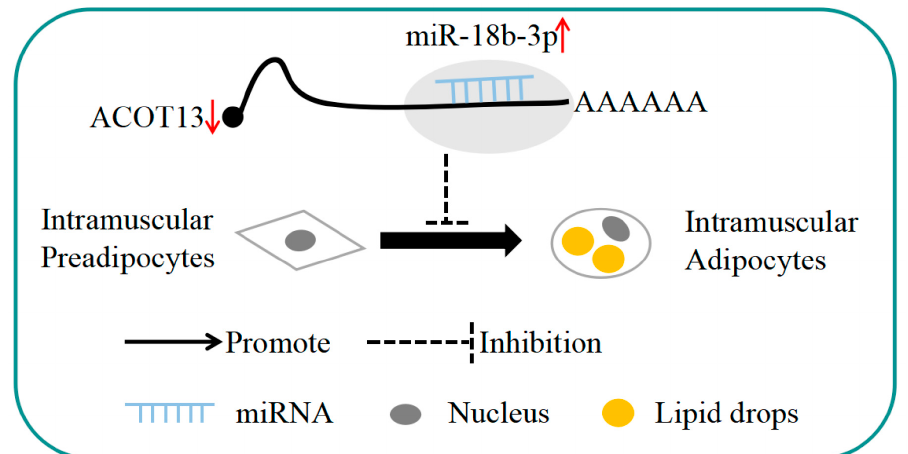
Figure 9. Proposed model of gga-miR-18b-3p regulation on intramuscular adipocyte differentiation.